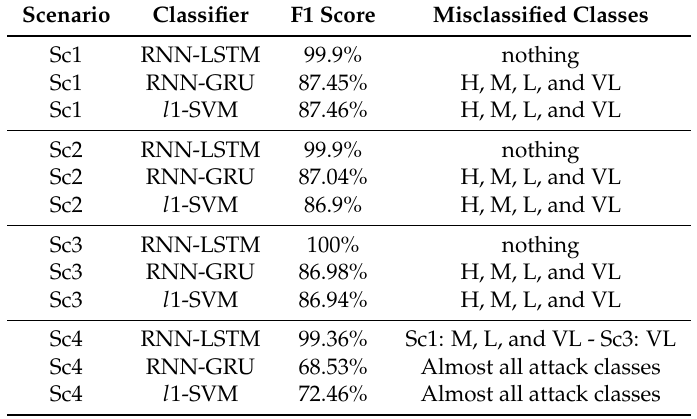
Table 2. Detection accuracy of the proposed approach (character-based feature extraction).